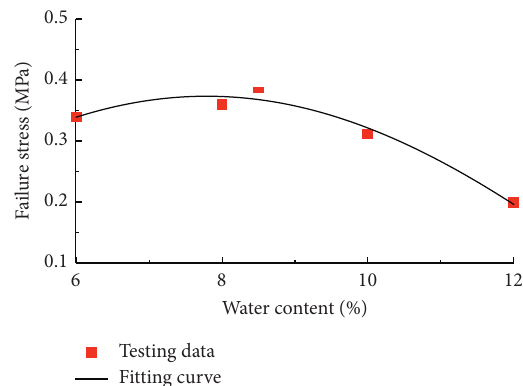
Figure 7: The relationship between water content and failure stress (confining pressure � 0.1MPa; compaction degree � 100).